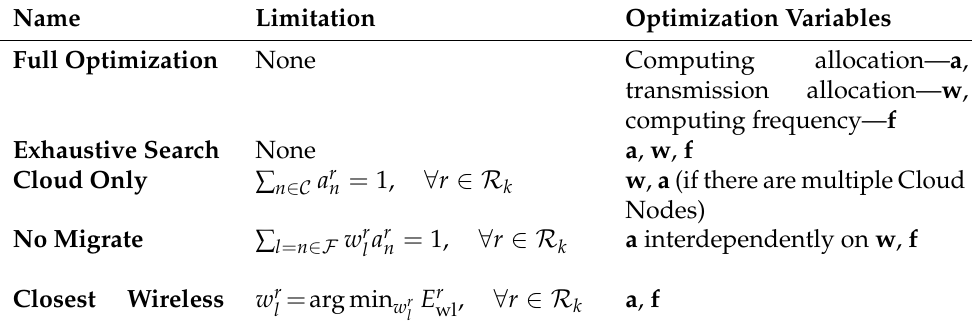
Table 5. Comparison of examined